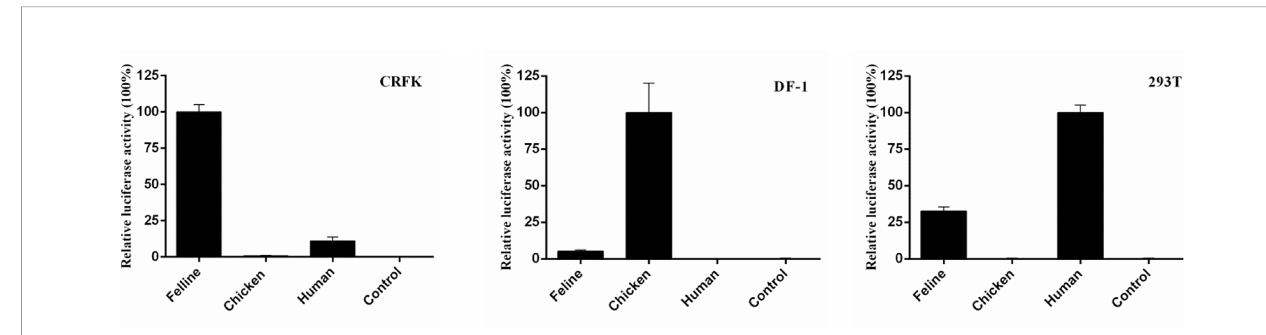
FIGURE 3 | Characterization of the species speci fi city characteristic of the feline RNA PolI promoter. Characterization of the species speci fi city characteristic of the feline RNA PolI using a dual-luciferase activity assay. Brie fl y, pHUpol-LUCI, pCHpol-LUCI, and pCAT250 were individually combined with the plasmids pCAGGs- WSN-PB2, pCAGGs-WSN-PB1, pCAGGs-WSN-PA, pCAGGs-WSN-NP and pRL-TK and transfected into CRFK, DF-1, and 293T cells in a 24-well plate, with the same transfection and data processing method described in Figure 2B . As a control, an empty plasmid with no PolI promoters was included to replace pHUpol- LUCI, pCHpol-LUCI, and pCAT250 in this